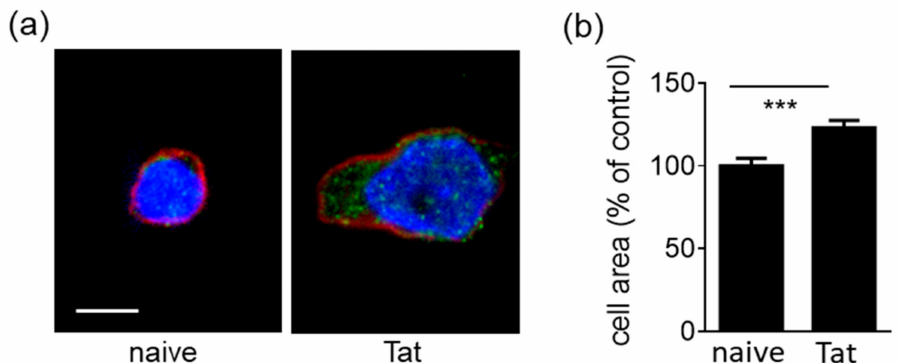
Figure 3. Tat tethered to syndecan-1 of lymphocytes promotes cell spreading onto an EC monolayer. ( a ) Representative microphotographs of naïve or Tat-presenting SYN-NCs adherent to the endothelial monolayer and immunostained with the specific probe for F-actin SiR-actin (red), phosphorylated FAK (green) and nuclei (blue) (scale bar 5 µ m). ( b ) The area of adherent Tat-presenting SYN-NCs was measured in 40 to 60 cells and expressed as mean percentage ± S.E.M. in respect to naive cells. *** p < 0.001, Student t